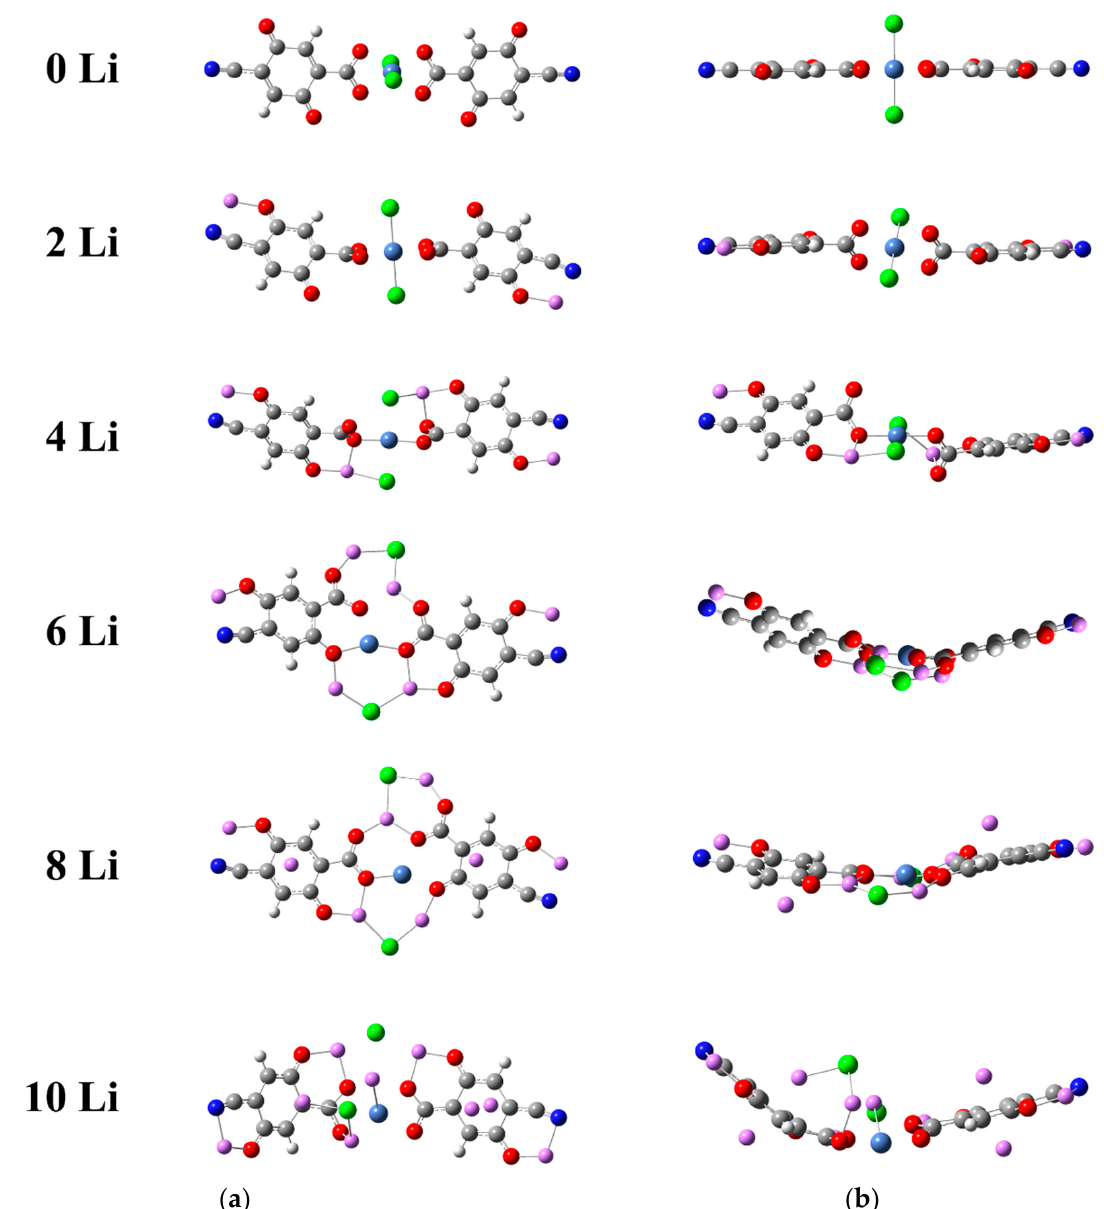
Figure 4. Stages of lithiation of Ni(IV)(L1) 2 —( a ) top and ( b ) side view of the optimized geometries. Color code: C—gray, H—white, O—red, N—deep blue, Ni—light blue, Cl—green, Li—pink.